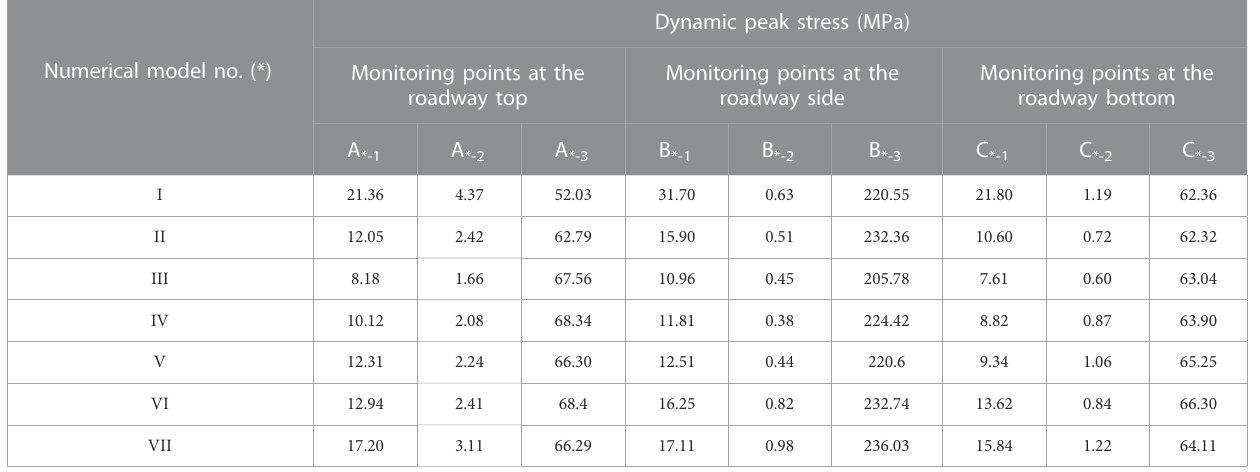
TABLE 5 Dynamic peak stress monitored in different numerical models.